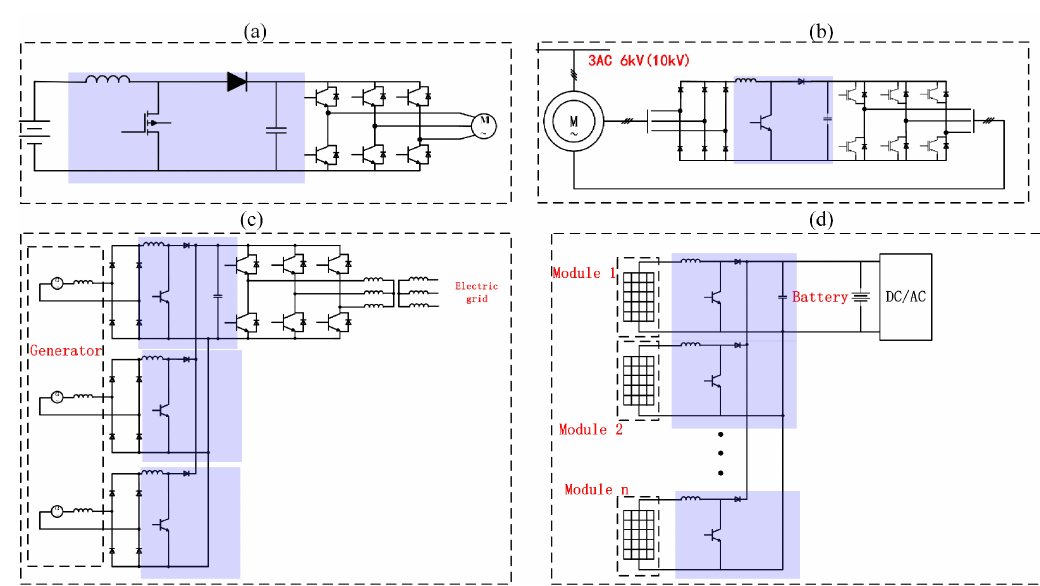
Figure 1. The application cases of a boost converter in a power system. ( a ) Battery-power system, ( b ) wound rotor asynchronous motor system, ( c ) wind generator system, ( d ) solar cell